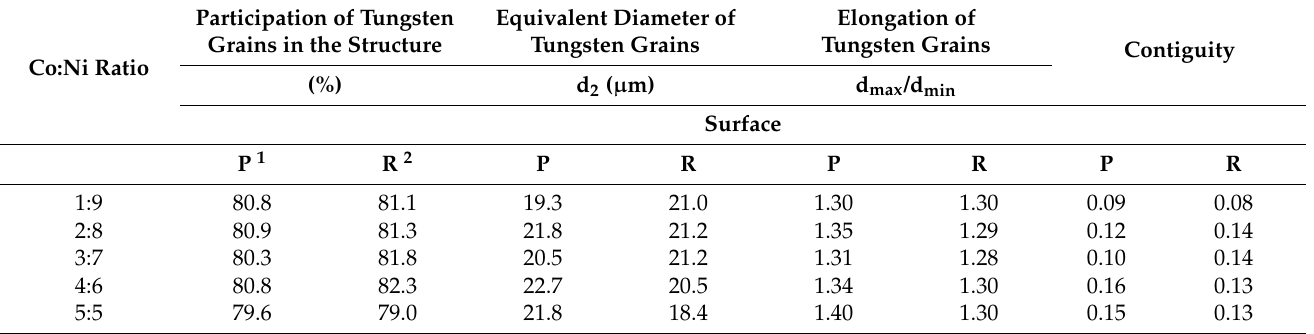
Table 4. Results of the WHA qualitative assessment carried out on specimens with metallographic parallel (R) and perpendicular (P) sections with respect to the main axis of the bar.